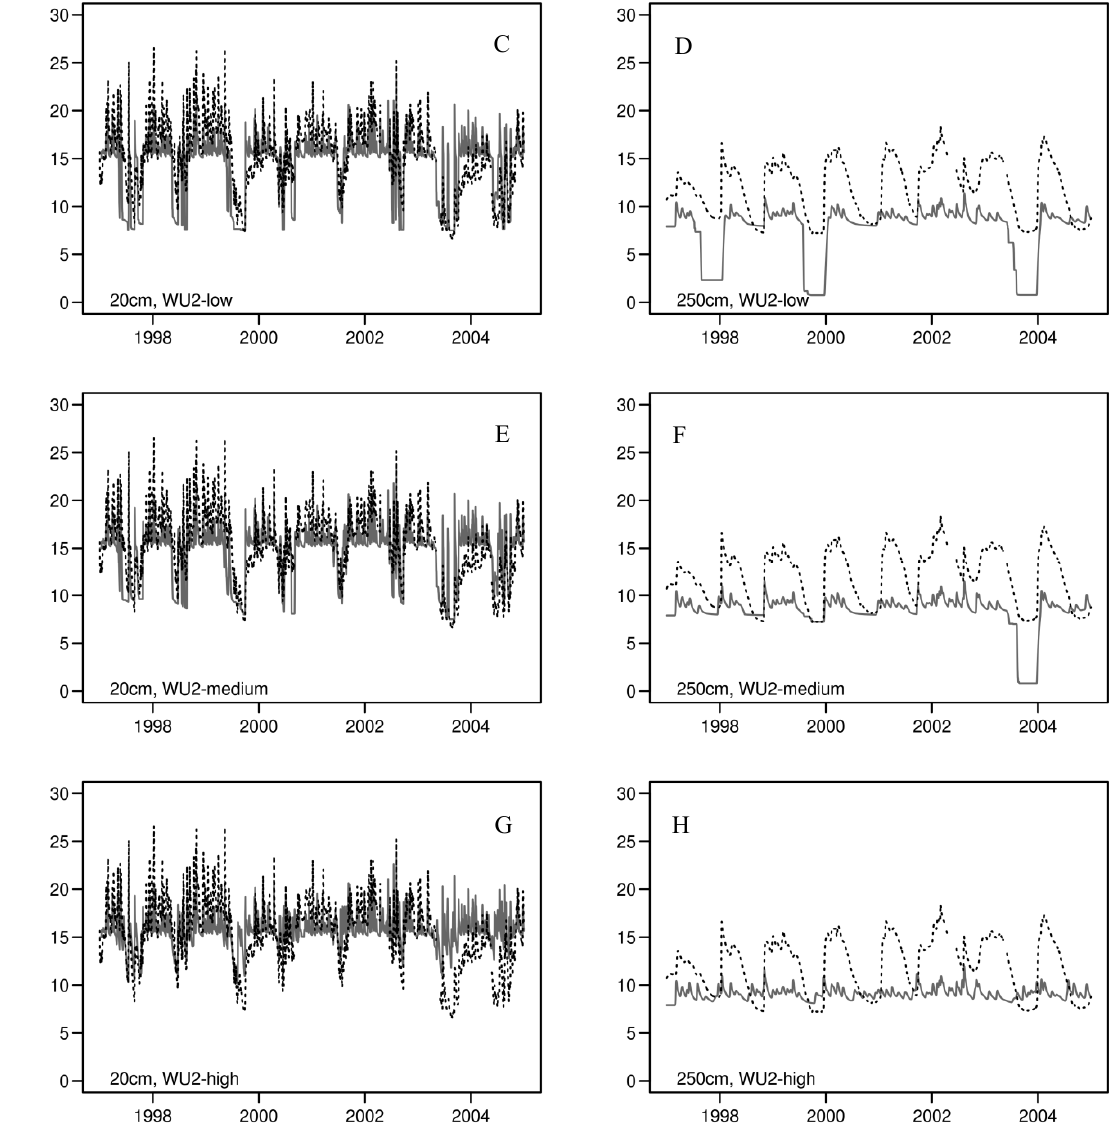
Figure 4. Volumetric soil water content at P1. The figure shows daily data for the upper soil layer (left panels; 20 cm) and lower soil layer (right panels; 250 cm). (( A , B ) = WU1; ( C , D ) = WU2-low; ( E , F ) = WU2-medium; and ( G , H ) =